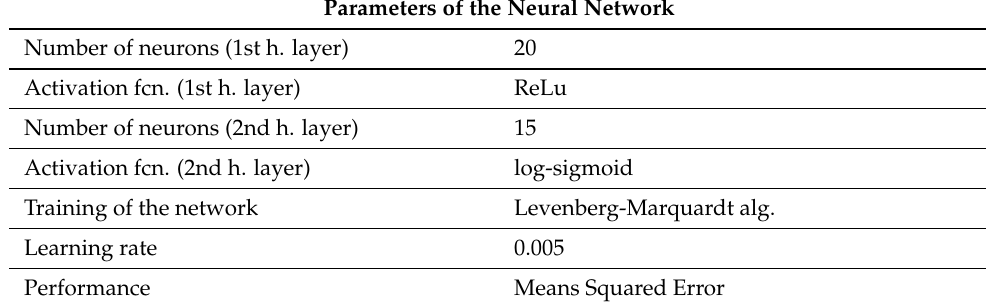
Table 1. Parameters of the neural network.